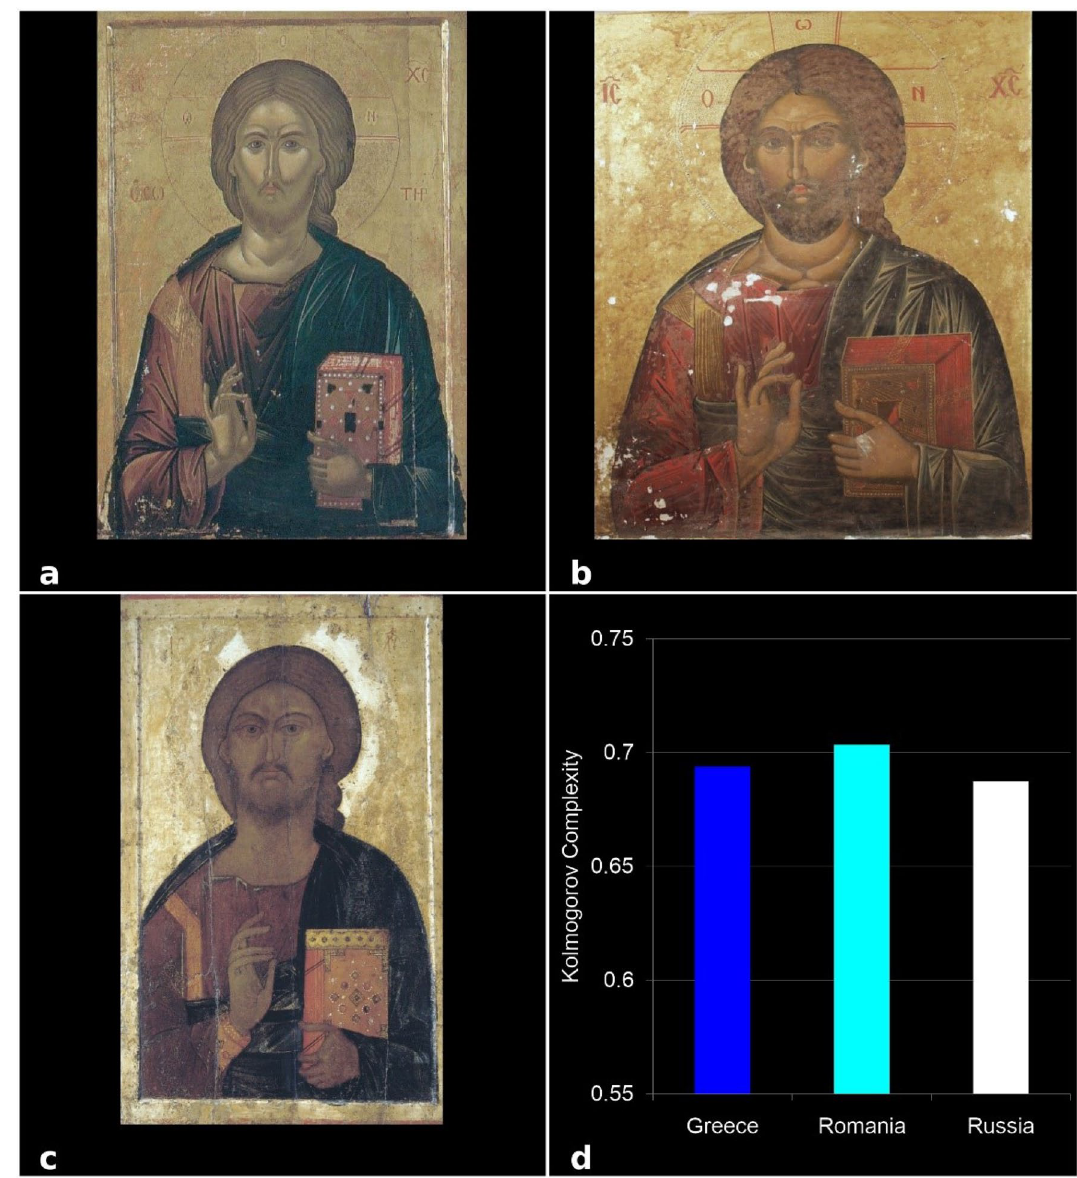
Figure 7. KC analysis of the Jesus Christ icons from the three schools of Byzantine iconographic paintings: ( a ) Greek, ( b ) Romanian, and ( c ) Russian school, ( d ) KC values. Each bar indicates a KC value of the single